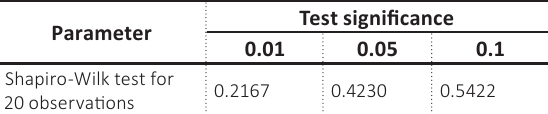
Table 3. Shapiro-Wilk test value for 20 observations